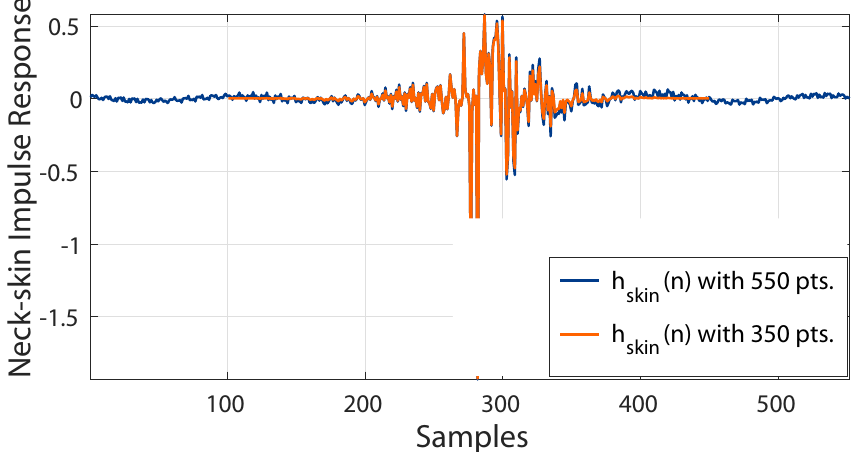
Figure 7. Neck-skin impulse response for a healthy female subject, full impulse (blue) and truncated version with a Hanning window